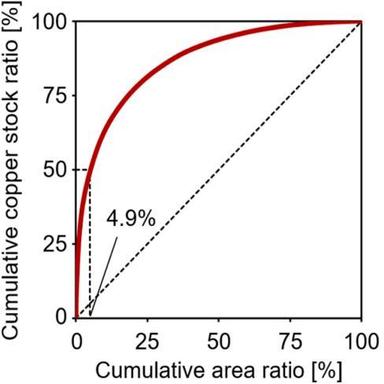
Cumulative copper stock curve for all final products in Japan in 2011.